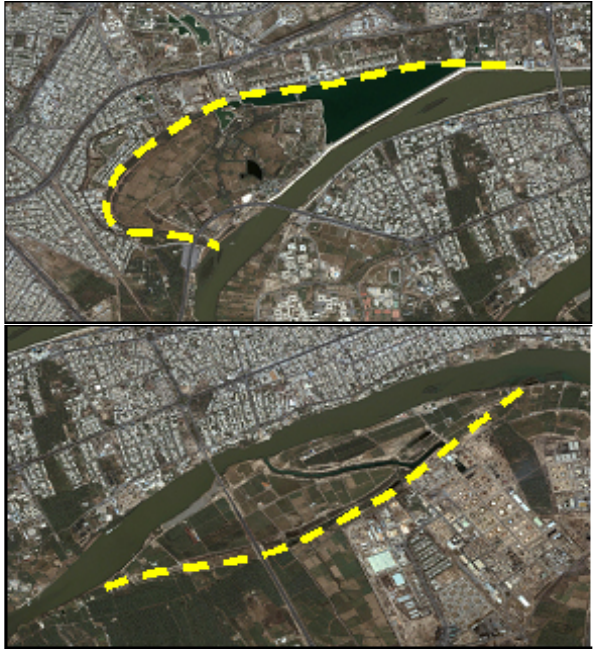
Fig. 7. Um Al-Khanazer and Abu Rumail islands after their right arms are